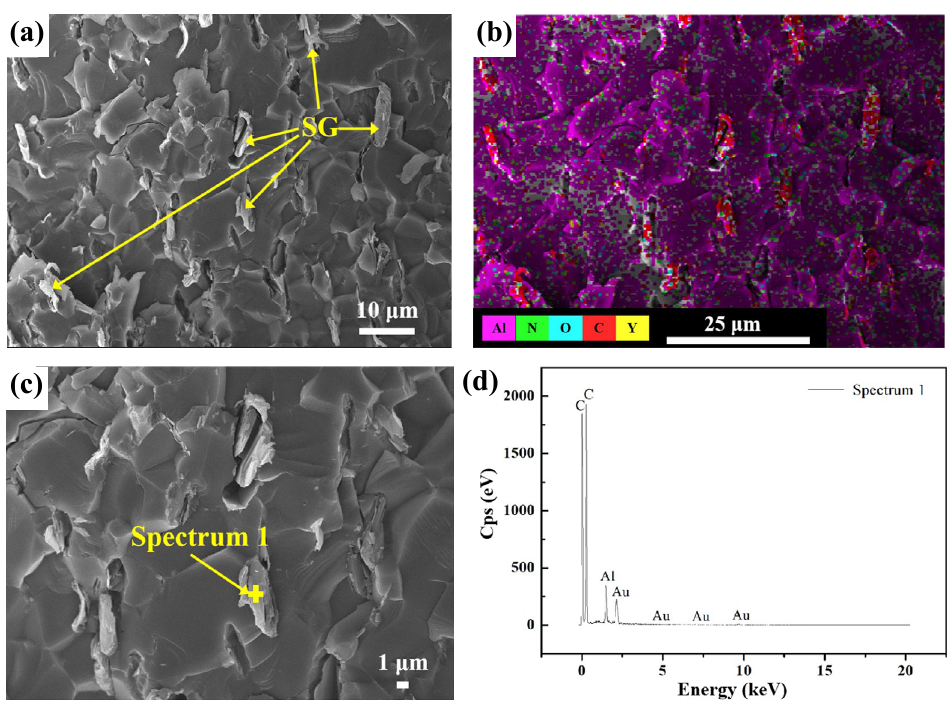
Fig. 6 (a) Microstructure, (b) EDS mapping, (c) high-resolution microstructure, and (d) EDS diagrams of 4 wt% SG/AlN composite without ultrasonic cleaning.